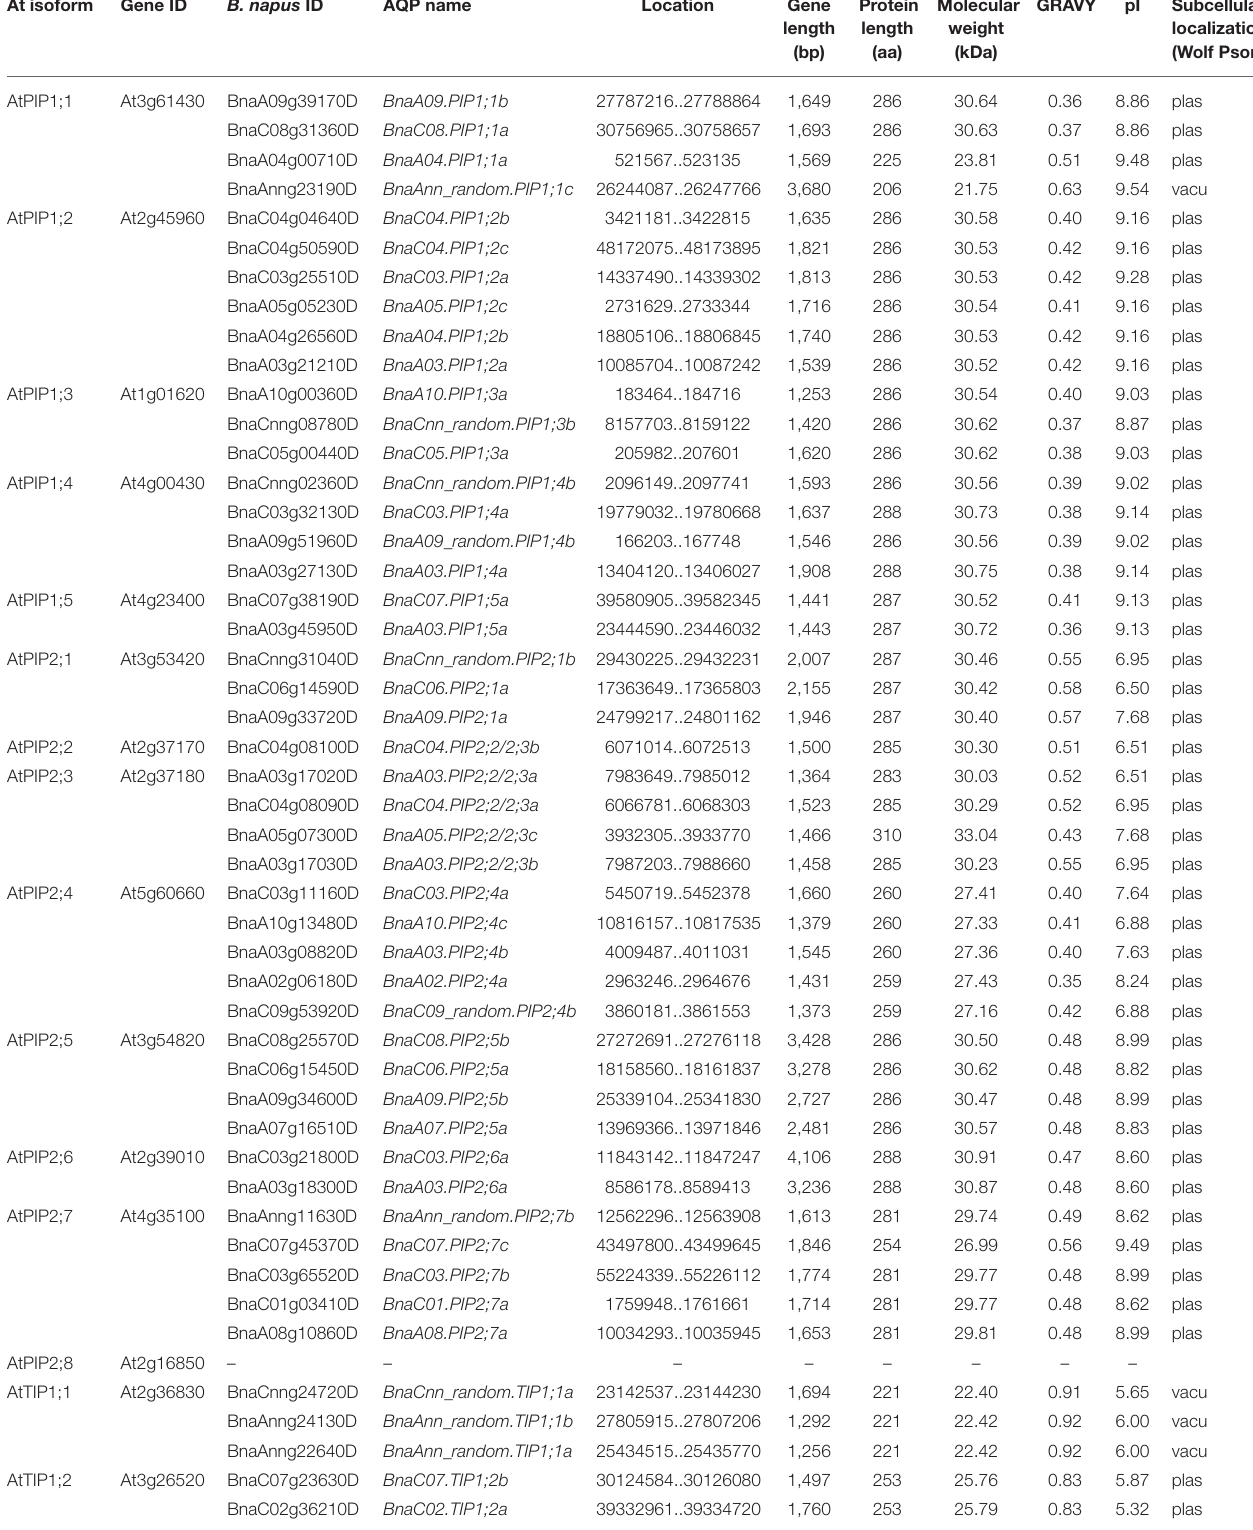
TABLE 1 | Gene sequence characteristics of 121 BnaAQP s and their protein physicochemical parameters and putative subcellular localization. At